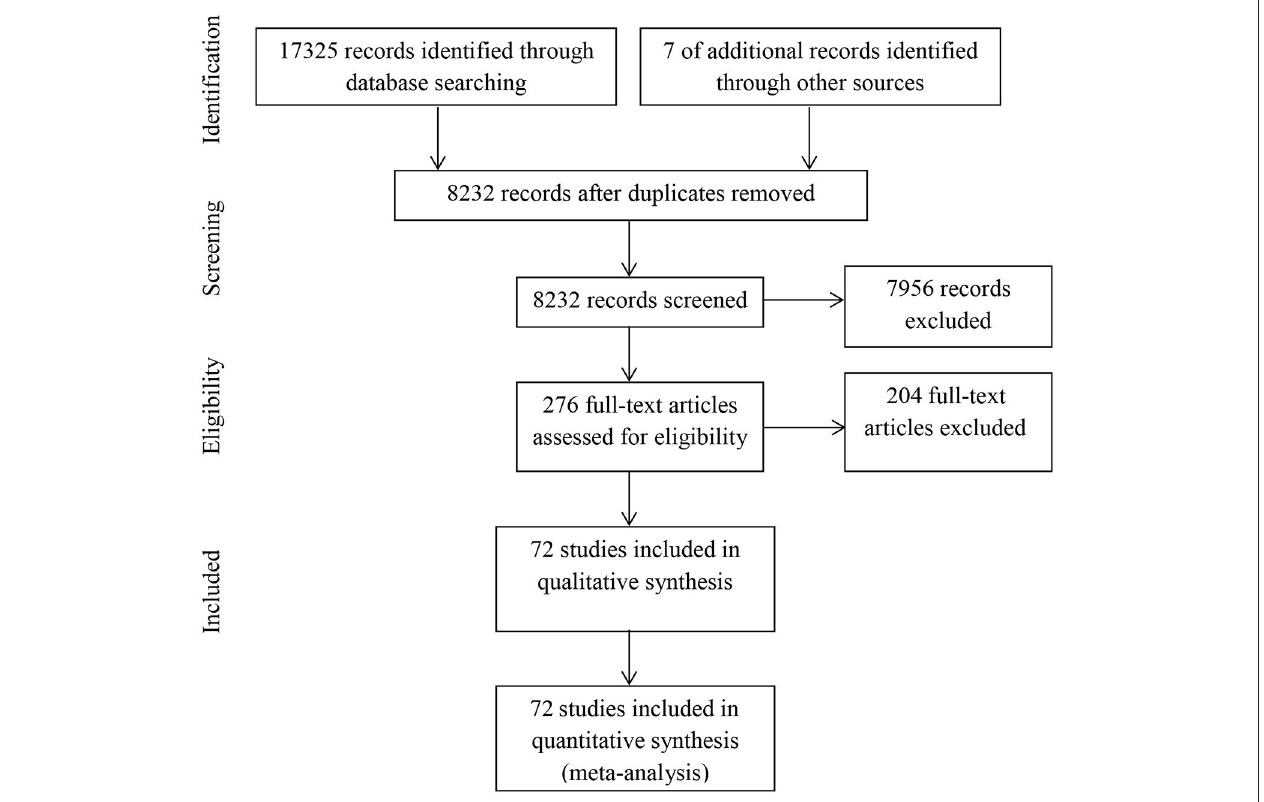
FIGURE 1 | Flow chart of study